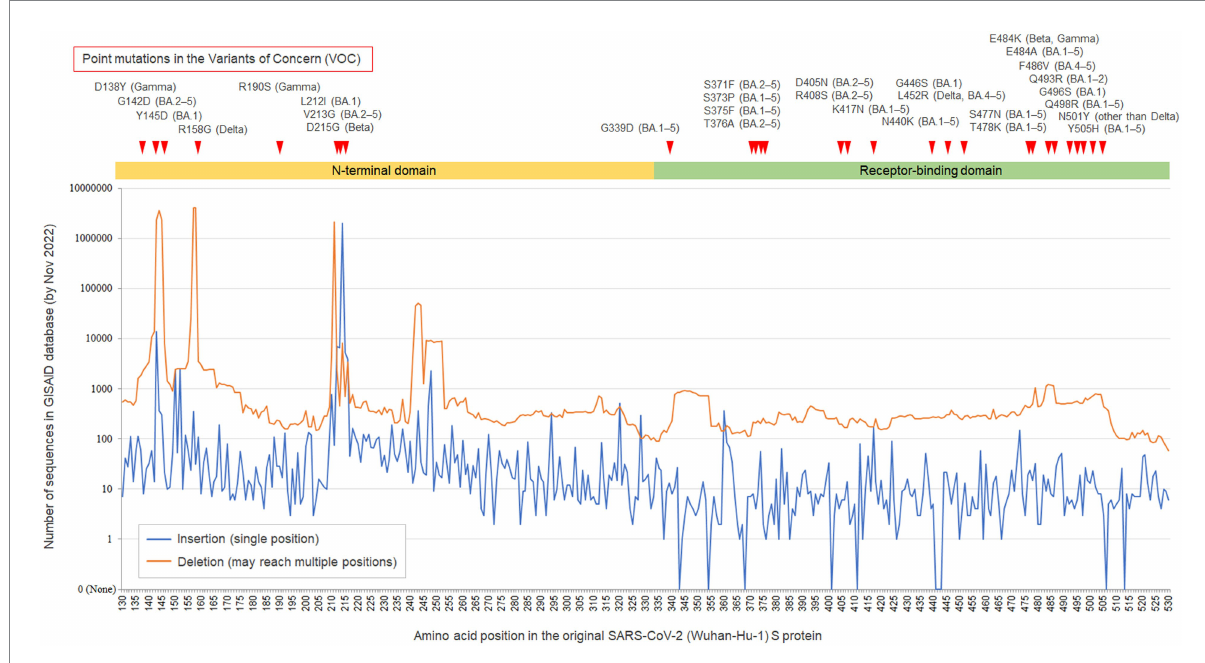
FIGURE 3 GISAID database search for the insertions/deletions in the N-terminal domain and receptor-binding domain of SARS-CoV-2 spike gene. The line graphs show the numbers of sequences sampled from humans with insertions/deletions (indels) at each amino acid position in the N-terminal domain (NTD) and receptor-binding domain (RBD) of the SARS-CoV-2 spike gene, which were registered in the GISAID database by December 01, 2022. The observed variable numbers tandem repeat of this study matches to the peak of insertion at 214 amino acid position of the S1-NTD. The asymmetrical line graphs suggest the different tolerability for incorporating indels between the SARS-CoV-2 S1-NTD and the S1-RBD, with a lower tolerability in the S1 RBD. The Y-axis scale is